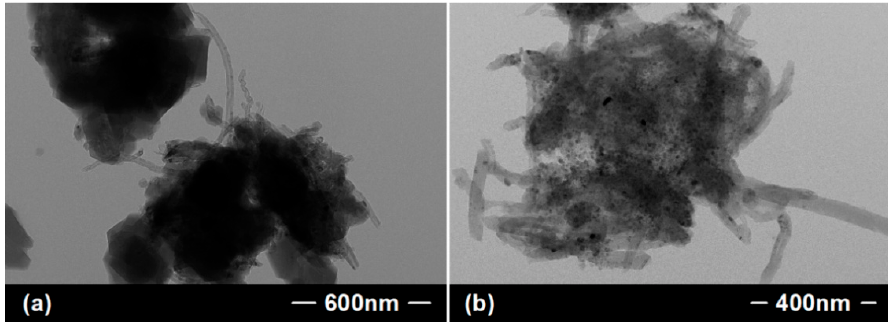
Figure 3. TEM images of ZIF-8/CNTs ( a ) and C ZIF-8/CNTs ( b ).